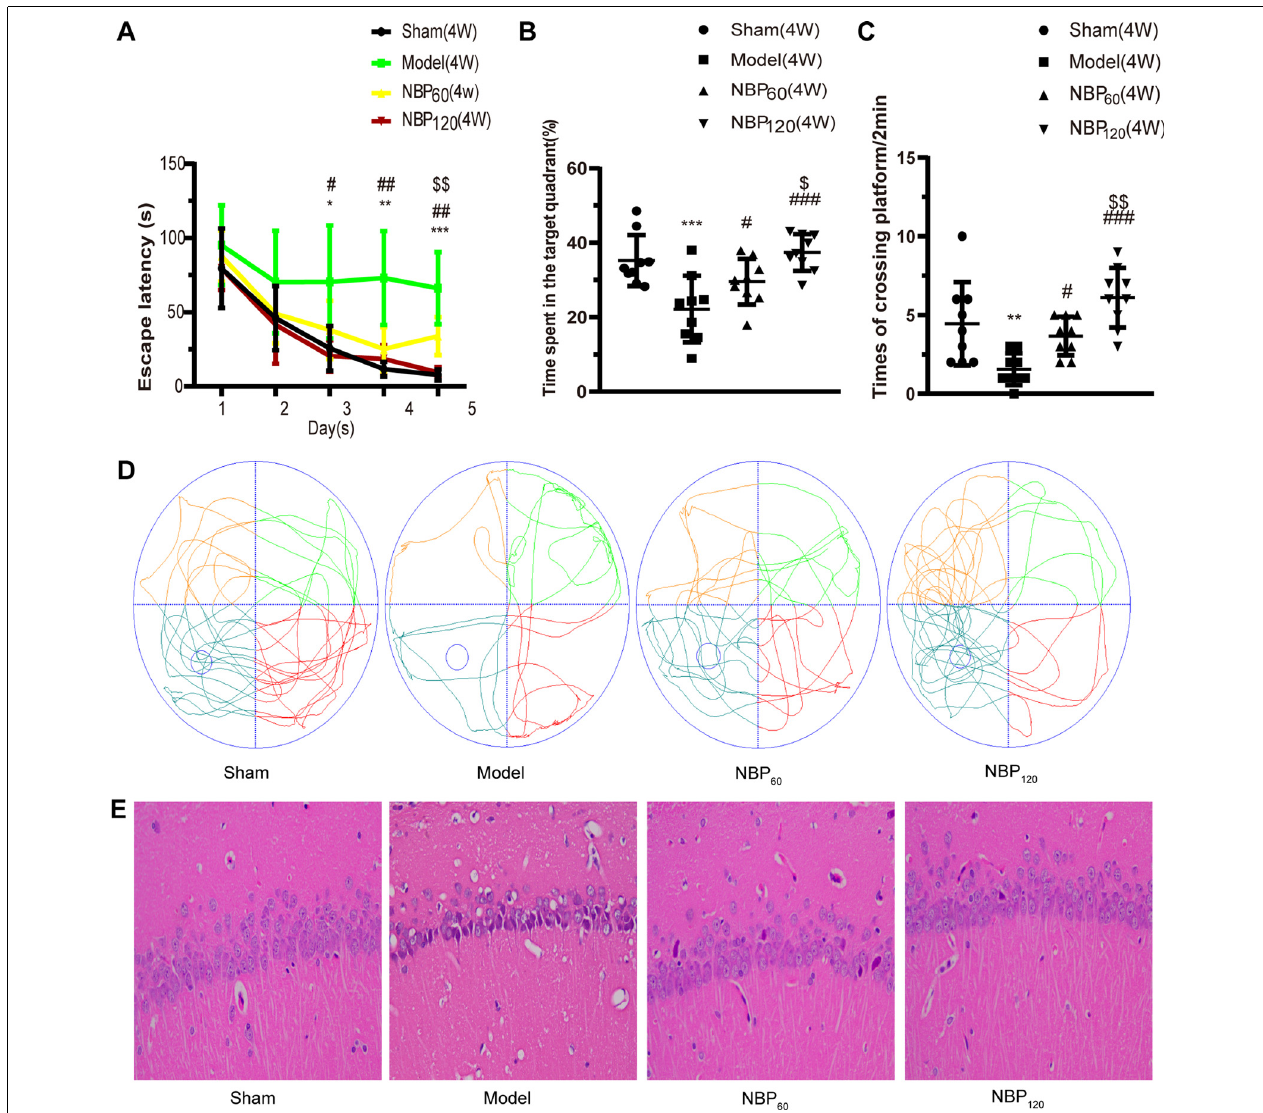
FIGURE 2 | Dl-3-n-butylphthalide (NBP) alleviates learning and memory deficiency, and the pathologic changes in hippocampal CA 1 region at 4 weeks after 2VO (Morris water maze, n = 9 in each group; Hematoxylin-eosin staining, n = 3 in each group). (A) Escape latency changes in different groups from day 1 to day 5. (B) Changes in time spent in the target quadrant (%) at day 6. (C) Changes in frequency of platform crossings in 2 min at day 6. (D) Swimming path of rats at day 6 in different groups. (E) Representative images of Hematoxylin-eosin staining in the hippocampal CA1 region. * p < 0.05, ** p < 0.01, *** p < 0.001, the model group vs. the sham group; # p < 0.05, ## p < 0.01, ### p < 0.001, the NBP60 group or NBP120 group vs. the model group; $ p < 0.05, $$ p < 0.01, the NBP60 group vs. NBP120 group. Values are expressed as mean ±